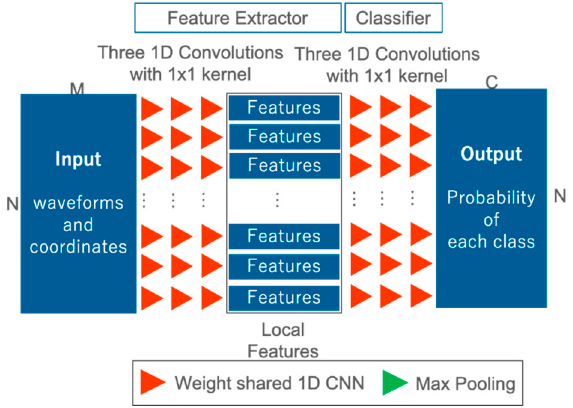
Figure 4. One-dimensional convolutional neural network (1D CNN) architecture (1D CNN Reproduce). Input: waveforms and coordinates; output: class probability.